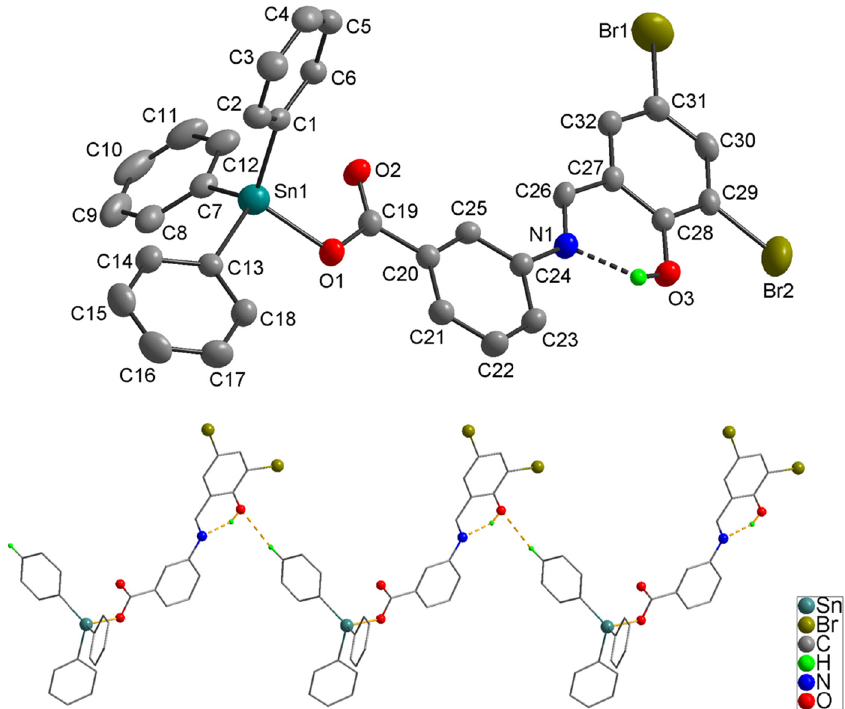
Figure 2: ( Top ) The molecular structure of 2. Ellipsoids are drawn at 30% probability level. Hydrogen atoms are omitted for clarity except H 3 atoms. ( Bottom ) One - dimensional supramolecular chain formed by the intermolecular C – H ⋯ O hydrogen